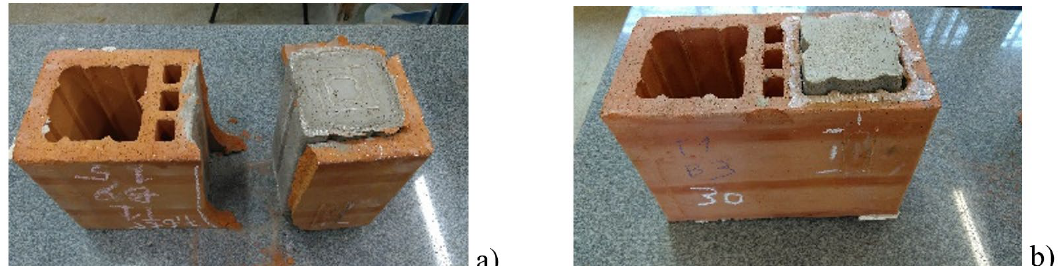
Figure 8. BM7 specimens after push-out test.